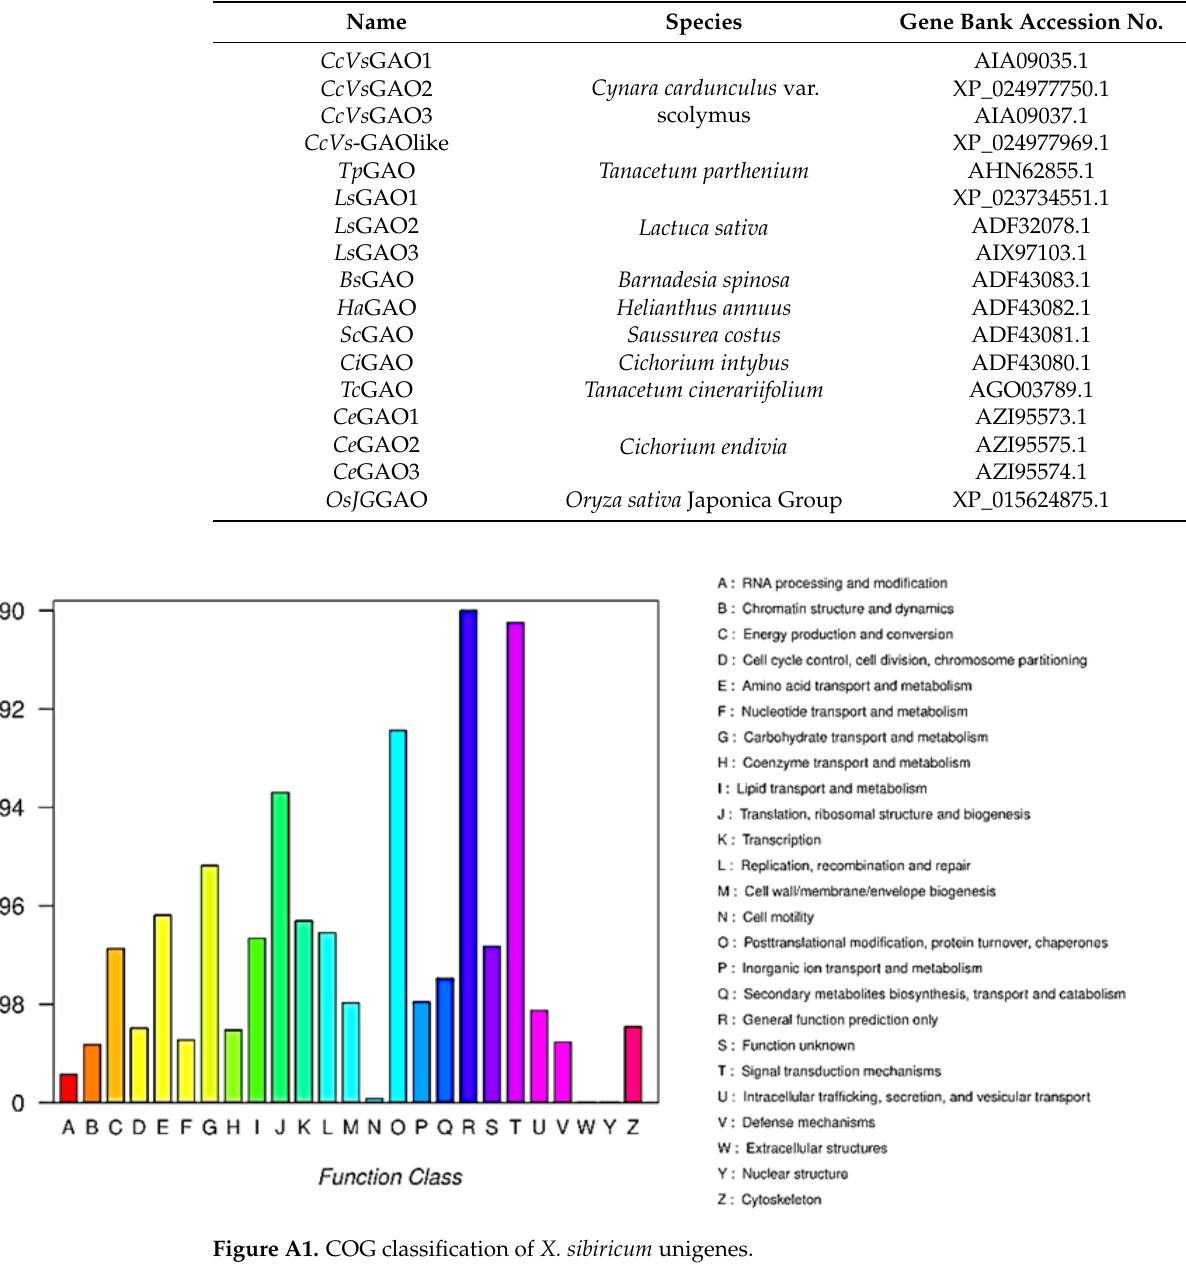
Table A3. Reference sequences used for phylogeny construction.